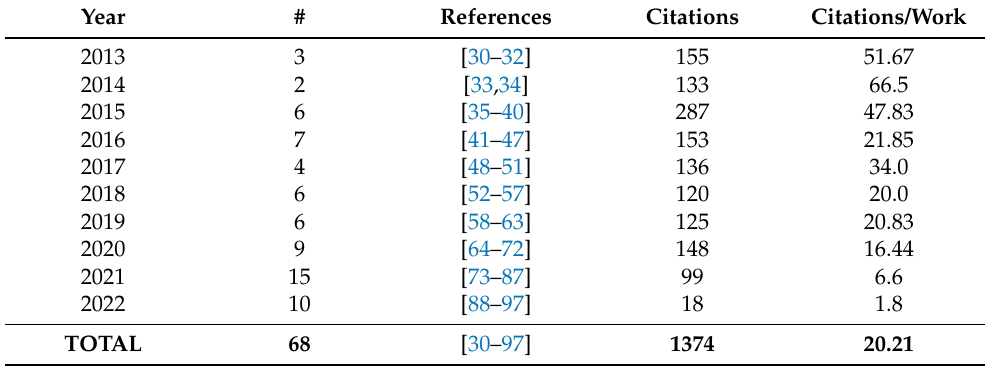
Table 4. Journal publications selected for this study, ordered by publication year.